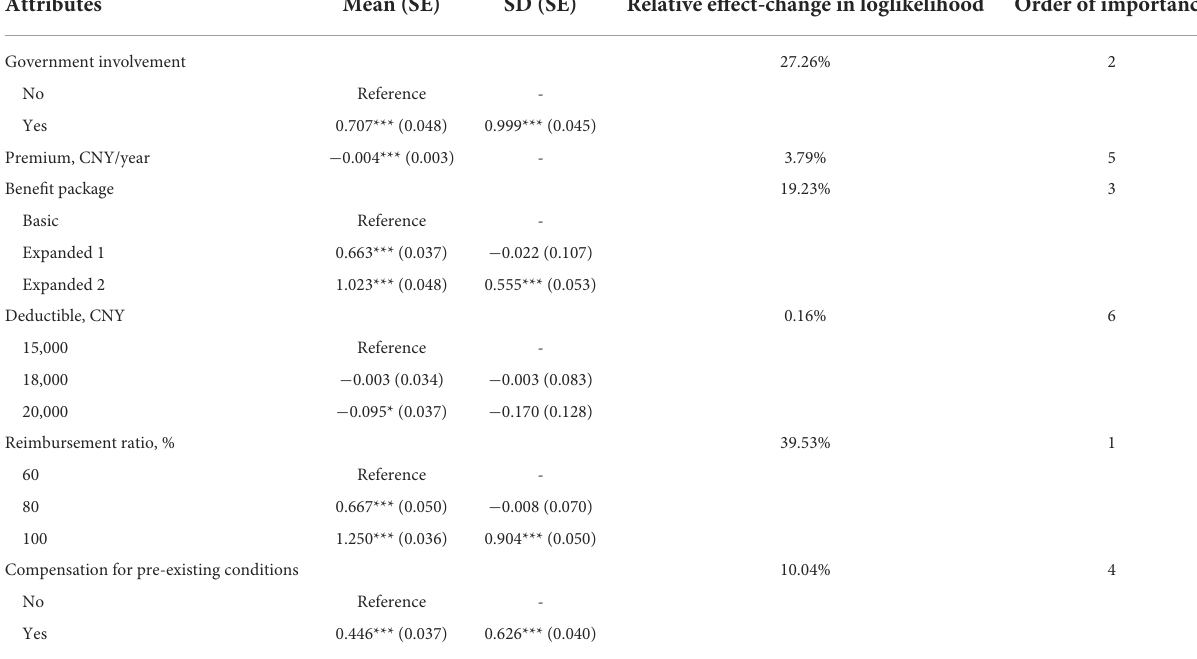
TABLE 4 Participants’ preferences for private health